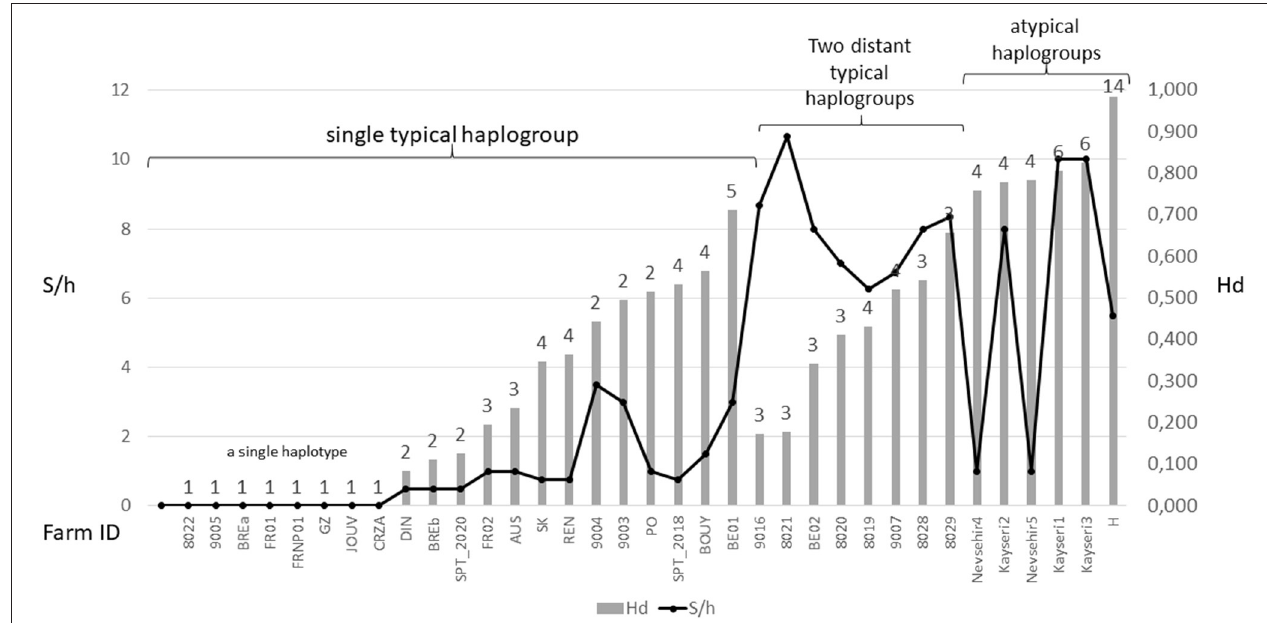
FIGURE 6 | Overview of diversity indices based on CO1 haplotypes in D. gallinae s.s. populations encountered in farms. The numbers above the bars represent the number of haplotypes encountered in each farm sample. Hd, haplotype diversity; S/h, ratio of the number of segregating sites to the number of haplotypes detected in an isolate. Values are ordered from left to right within three different mt profiles: populations carrying a single typical haplogroup, populations carrying two or three typical haplogroups including C and populations carrying any atypical haplogroups. The data set is presented in Supplementary Material 3 . High S/h values were always recorded in farms where haplogroup C and one or two of the other haplogroups were found together, regardless of the Hd value. High Hd values ( > 0.75) were found in farms where atypical haplotypes have been amplified (haplogroups E, F, and H), likely due to the rapid evolution of the non-functional